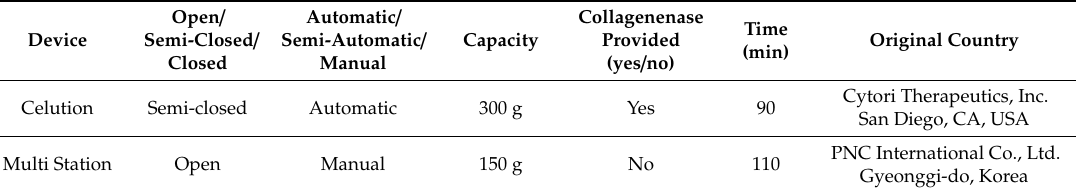
Table 2. List of current systems for adipose stem cells